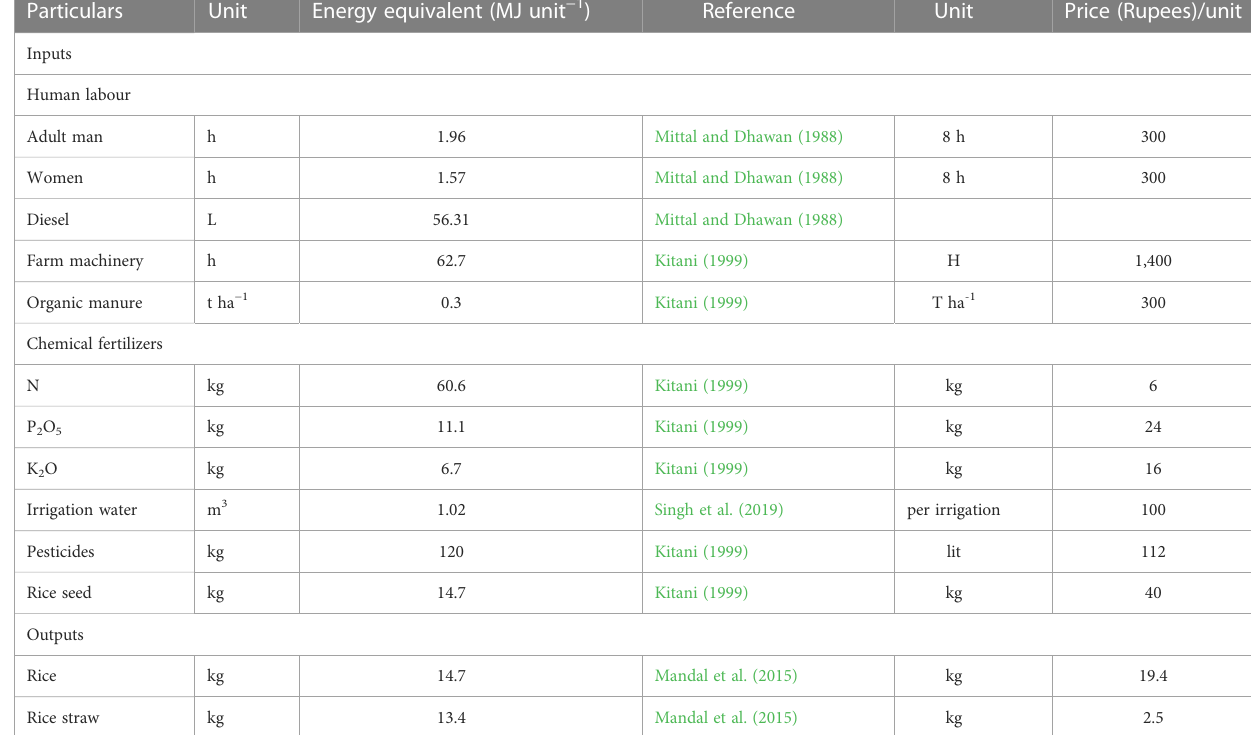
TABLE 2 Energy equivalents and price of inputs and outputs in agricultural production.